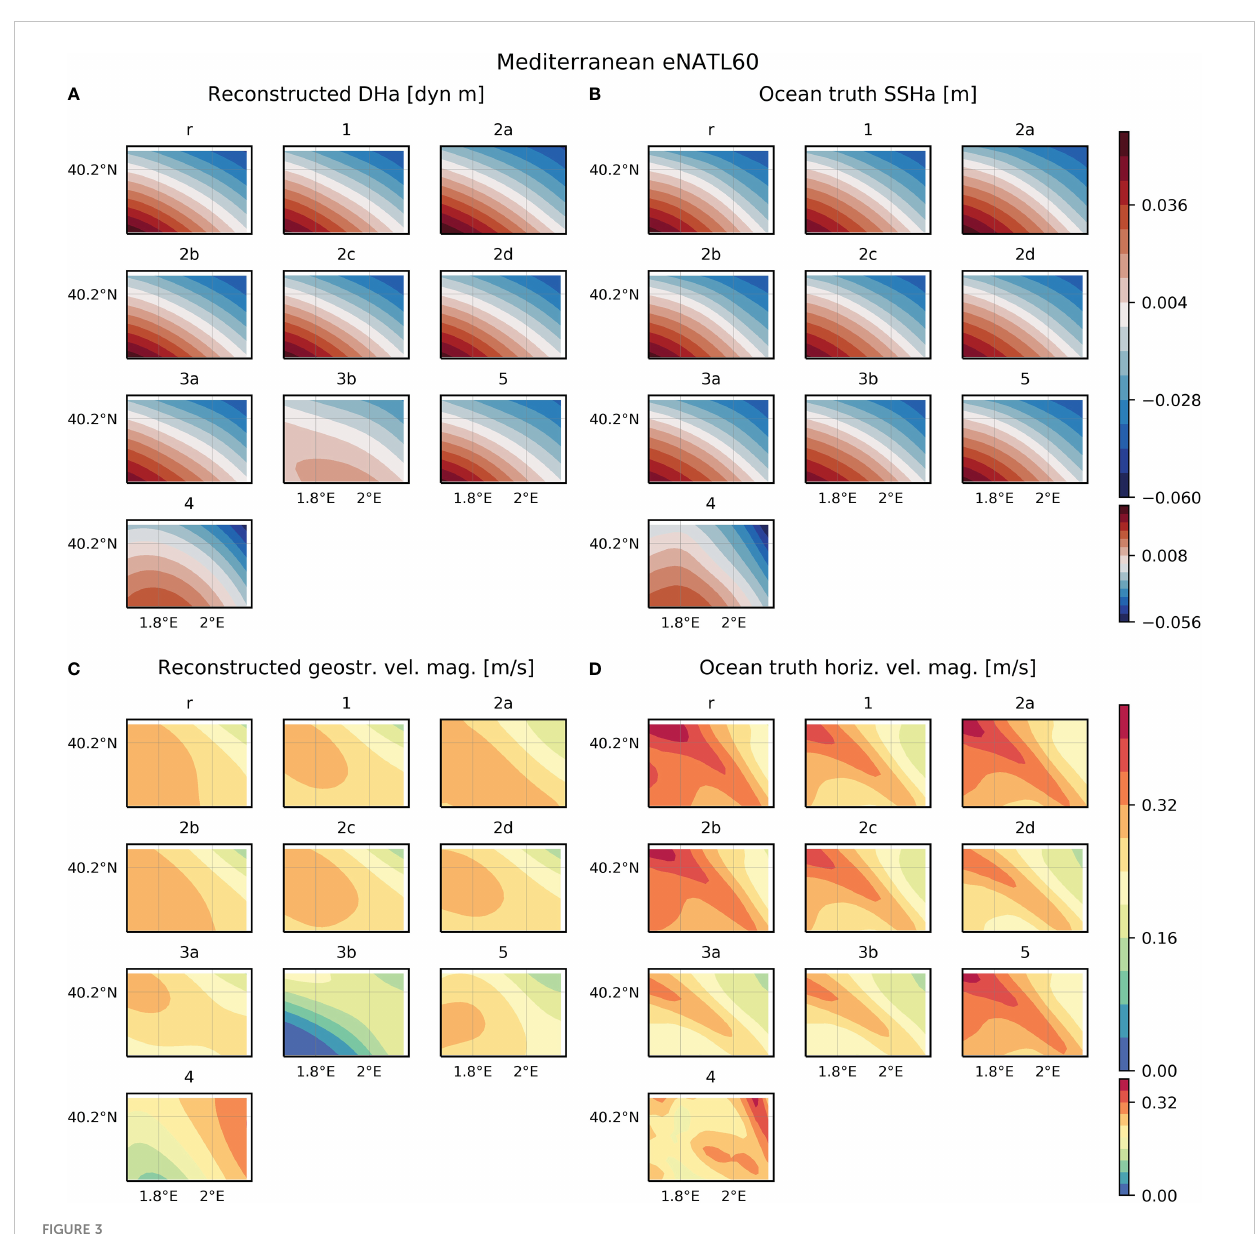
FIGURE 3 (A) Dynamic height anomaly (DHa) at the upper layer reconstructed from each con fi guration simulated from the eNATL60 model in the Mediterranean study region. (B) Sea surface height anomaly (SSHa) from eNATL60 on the same date as each reconstruction. To compute anomalies, the spatial average is subtracted to the corresponding fi eld. (C) Geostrophic velocity magnitude at the upper layer reconstructed from each con fi guration simulated from eNATL60 in the Mediterranean study region. (D) Horizontal velocity magnitude from eNATL60 on the same date as each reconstruction. Note that to calculate statistics model fi elds are interpolated onto the reconstruction grid and statistics are computed only considering data within the domain of con fi guration